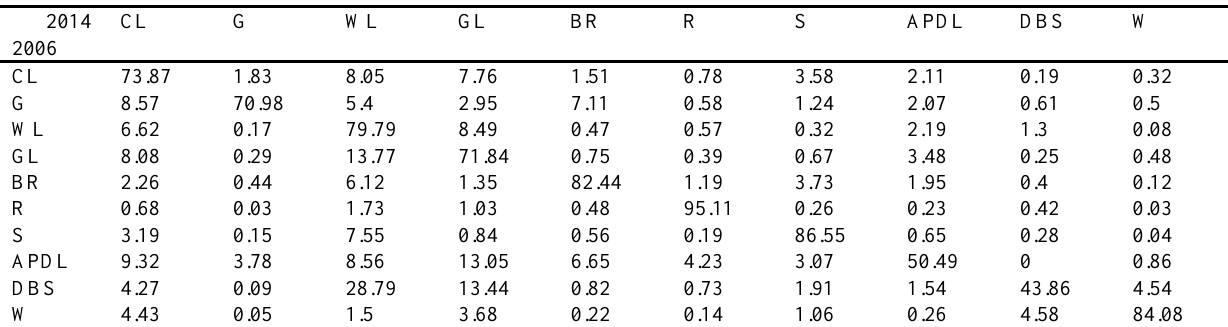
Table 2. Transition probability of land use type between 2006 and 2014 （ unit: /% ） Water and building transition probability is lower between 2006 and 2014.